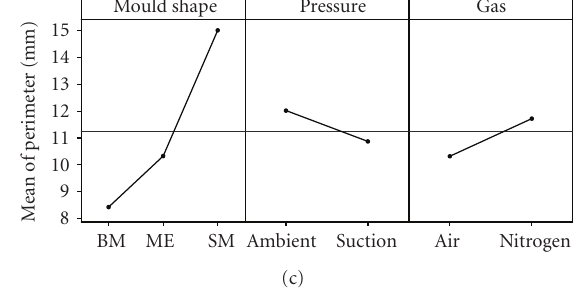
Figure 18: Area, perimeter, and wall thickness of cells versus process